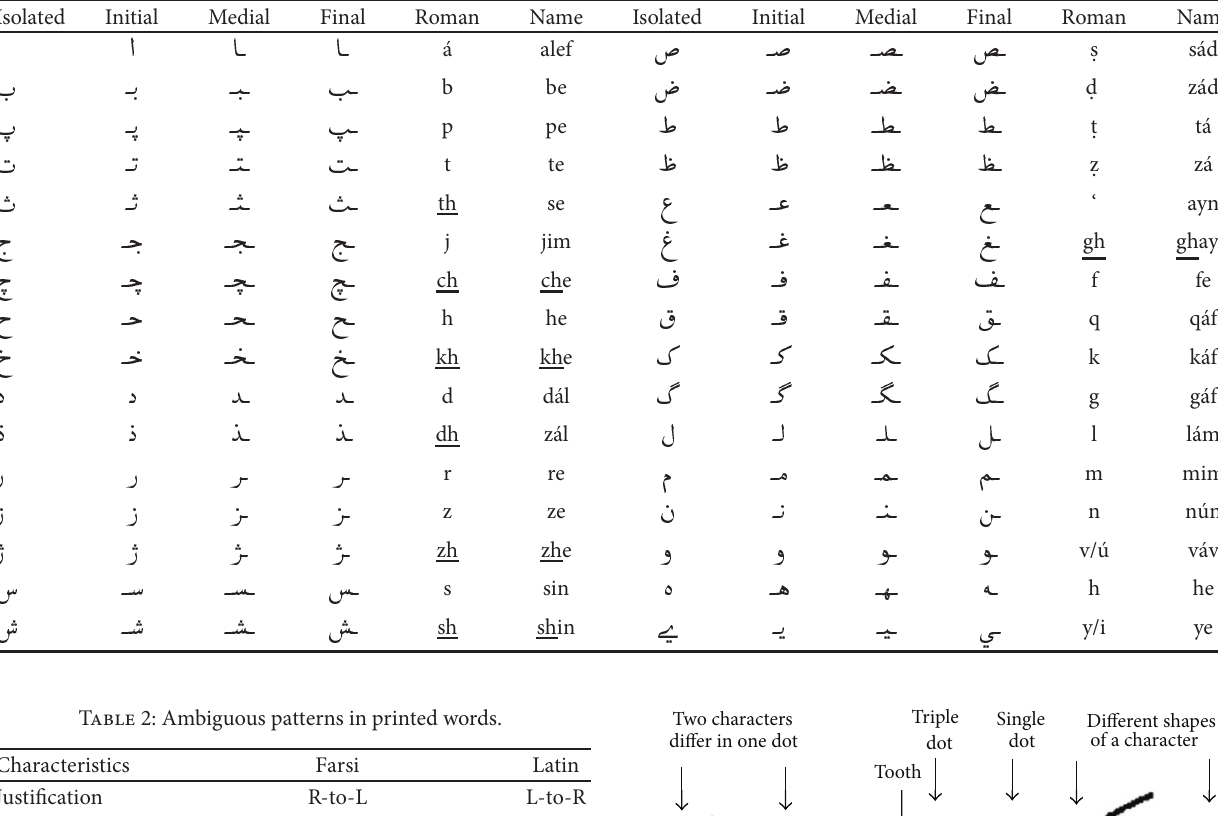
Table 1: Four different shapes of letters in the Persian alphabet [28].